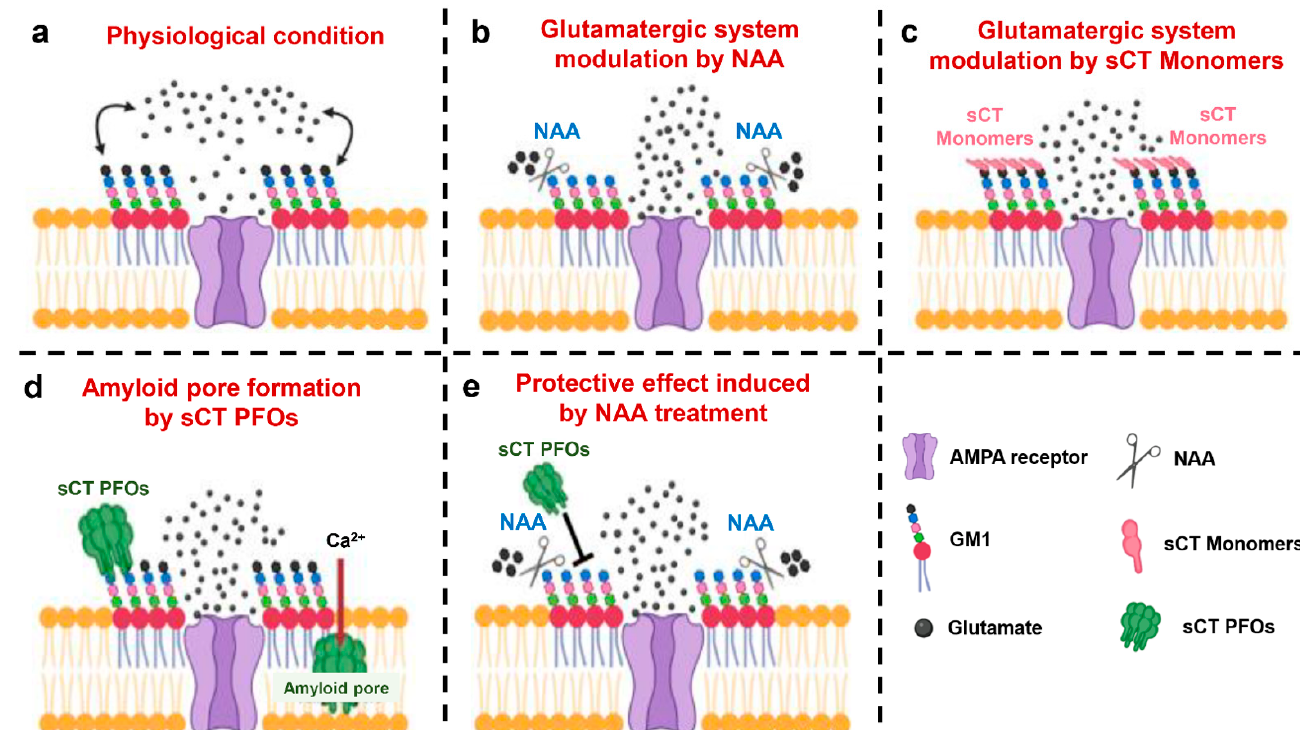
Figure 3. A novel model to explain the role of electrostatic interactions involved in the mechanism of action of calcitonin oligomers and monomers. ( a ) Physiological condition: the negative charges of the sialic acid contained in the monosialo- tetrahexosylganglioside (GM1) generate an electrostatic field that partially repels the anionic neurotransmitter glutamate, promoting fine tuning of the glutamatergic system. ( b ) Modulation of the glutamatergic system by Neuraminidase (NAA): the action of NAA removes negatively charged sialic acid residues from GM1, resulting in an alteration of the membrane surface charges and in the increase of the relative concentration of the anionic neurotransmitter glutamate near to the alpha-amino-3-hydroxy-5-methyl-4-isoxazolepropionic acid (AMPA) receptor. ( c ) Modulation of the glutamatergic sys- tem by salmon Calcitonin (sCT) monomers: the binding of positive sCT monomers with GM1 masks the negative charges of the sialic acid residues, reducing the electrostatic repulsion between the anionic neurotransmitter glutamate and the membrane. ( d ) Formation of the amyloid pore by Prefibrillar Oligomers of salmon Calcitonin (sCT PFOs): the electrostatic interaction between the positive charges of sCT PFOs and the negative charges of GM1 drives the oligomer insertion into the membrane, resulting in the amyloid pore formation and toxicity. ( e ) Protective effect induced by NAA treatment: removal of negatively charged sialic acid residues from GM1 by NAA prevents electrostatic interaction between sCT PFOs and membrane counteracting amyloid pore formation and neurotoxicity.